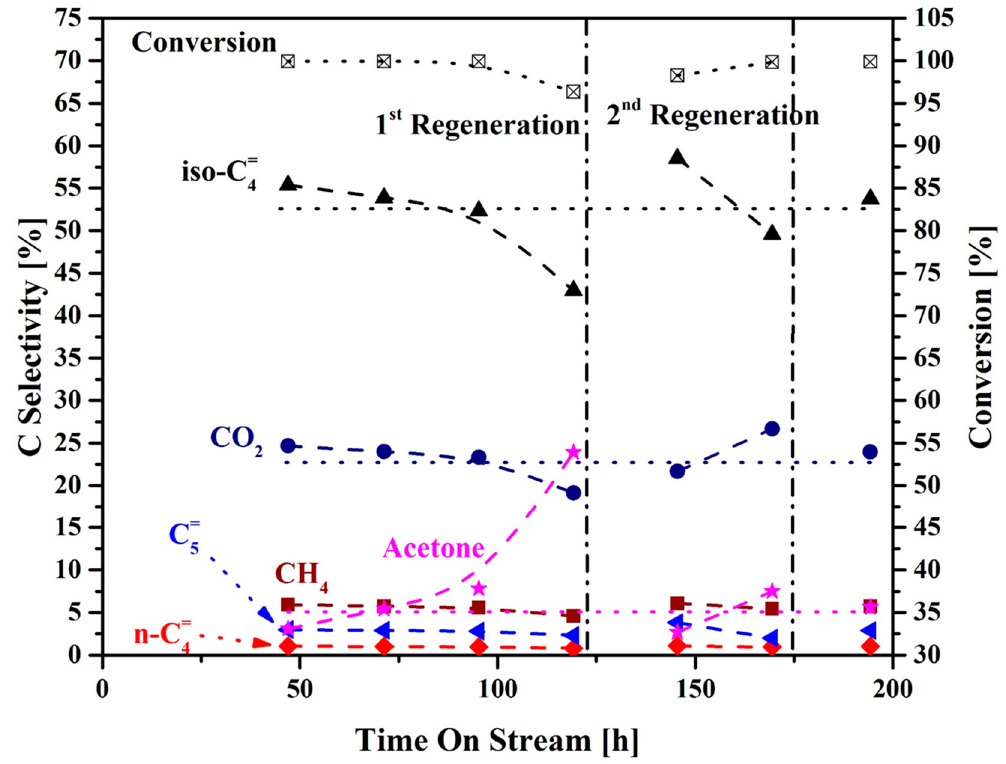
Figure 5. Stability and regeneration of USDA-FP feedstock. Temperature: 450 °C, S/C = 11.2, GHSV: 1200 h − 1 , catalyst loading 0.7 g, N 2 50 vol%. The catalyst regeneration was done by calcination in 5 vol% O 2 in N 2 at 500 °C for 4 h.